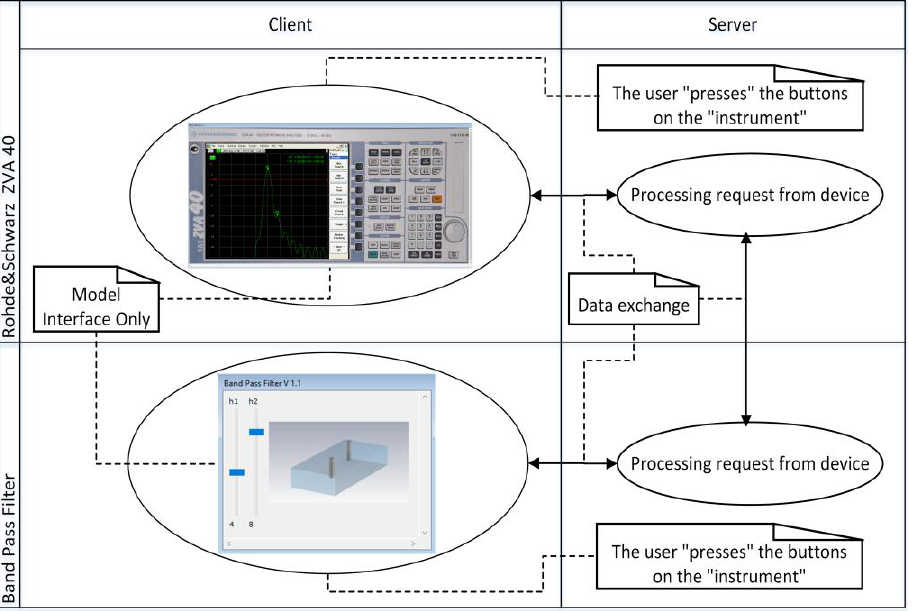
Fig. 2. Interaction of device models in a virtual